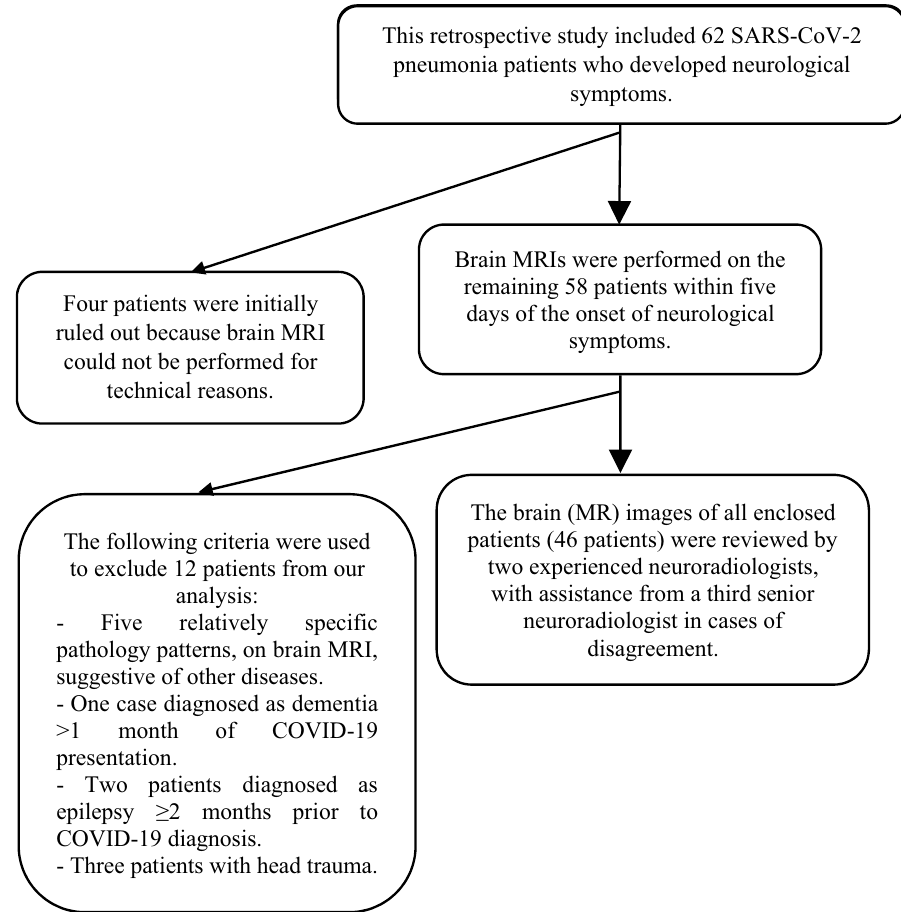
Figure 1. Depicts the descriptive selection of RT-PCR confirmed SARS-CoV-2 pneumonia patients, presented with neurological manifestations and subjected to brain MRI, that are enclosed in this study